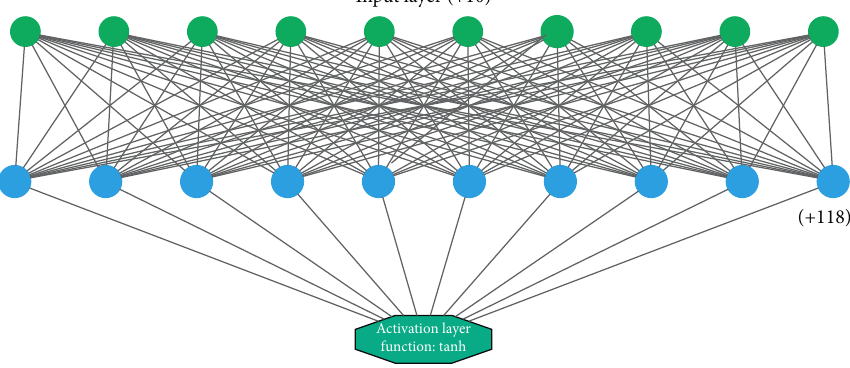
Figure 1: ANN structure